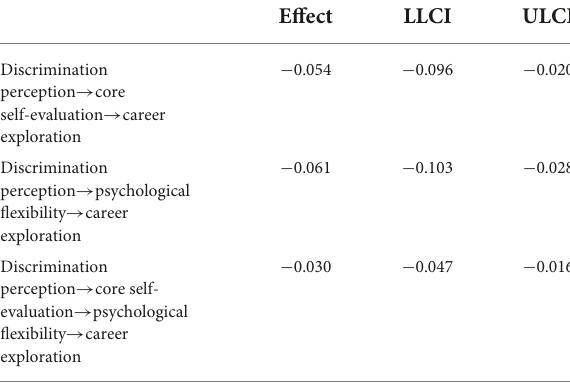
intervals were calculated, and the mediating effect was significant if the confidence interval did not contain 0 ( Table 2 ). The mediating effect of core